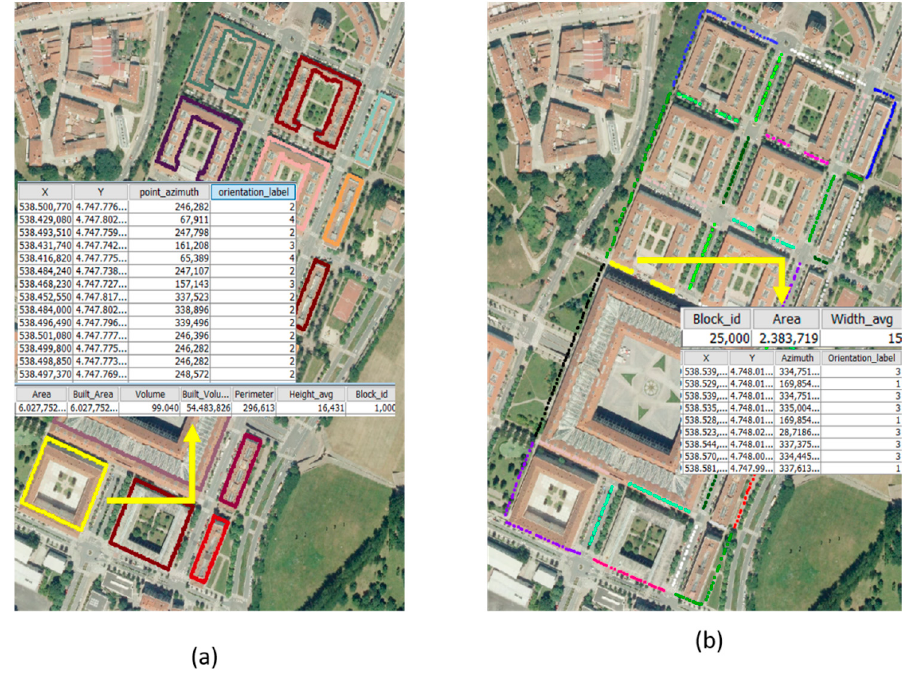
Figure 13. Visualization of the results as a GIS shape layer which overlaps an orthophoto of the case study area. ( a ) Building block parameters can be visualized either point-wise (azimuth and orientation label) or block wise (area, volume, etc.). ( b ) Street parameters can be similarly visualized.